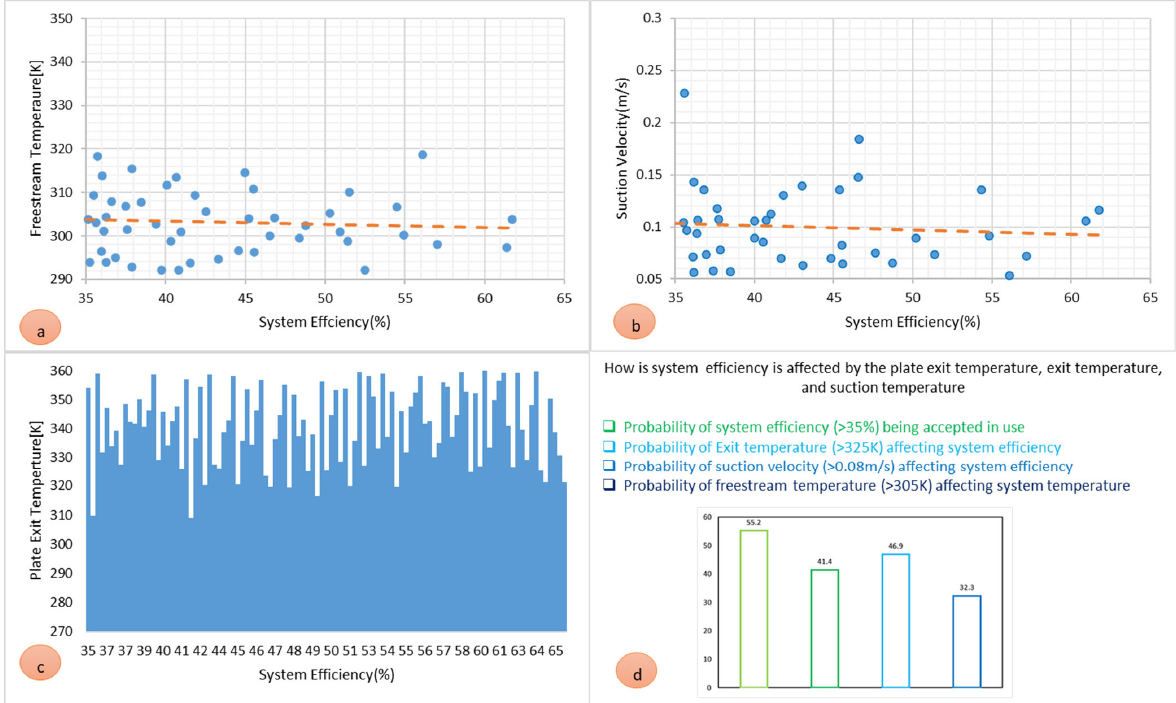
Figure 6. ( a ) Probability of freestream temperature ( b ) Probability of suction velocity ( c ) Probability of plate exit temperature ( d ) Combined Probability graph.